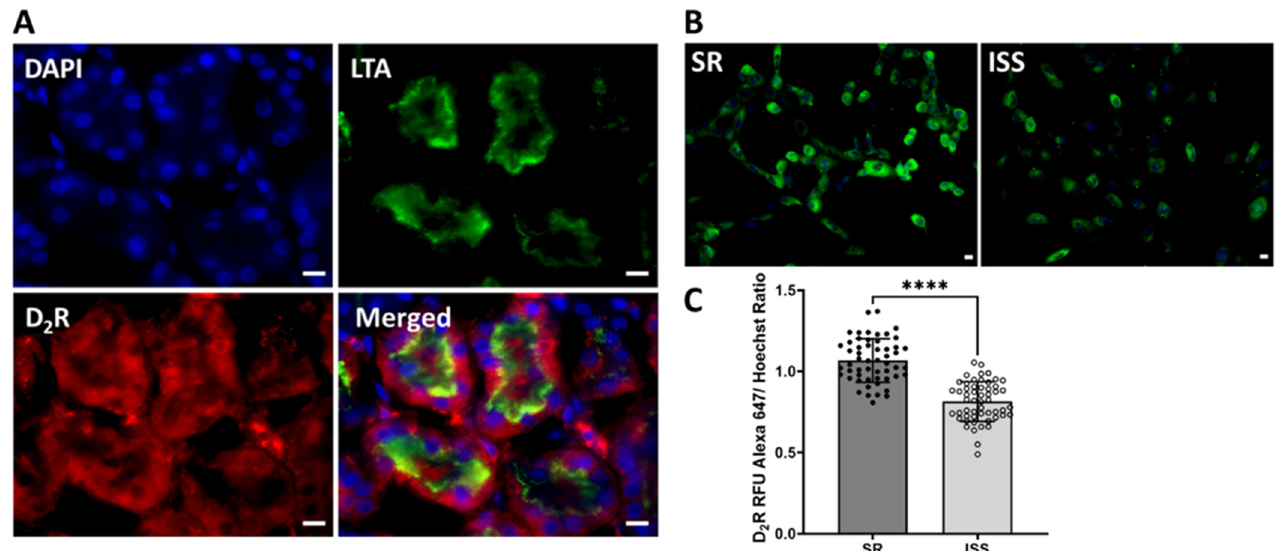
Figure 2. D 2 R immunostaining in human kidney and renal proximal tubule cells. ( A ) D 2 R is stained red in the kidney. LTA, Lotus tetragonolobus , a proximal tubule marker. ( B ) Plasma membrane expression of D 2 R in renal proximal tubule cells. Nuclei are stained blue. Scale bar = 10 µm ( C ) Plasma membrane D 2 R expression, using an extracellular epitope-specific anti-D 2 R polyclonal antibody directly labeled with Alexa 647, is lower in fixed uRPTCs from individuals with ISS than individuals with SR (SR, 1.07 ± 0.02; vs. ISS, 0.81 ± 0.02; **** p < 0.001, n = 54; t -test). ISS = inverse salt-sensitive; SR = salt-resistant.